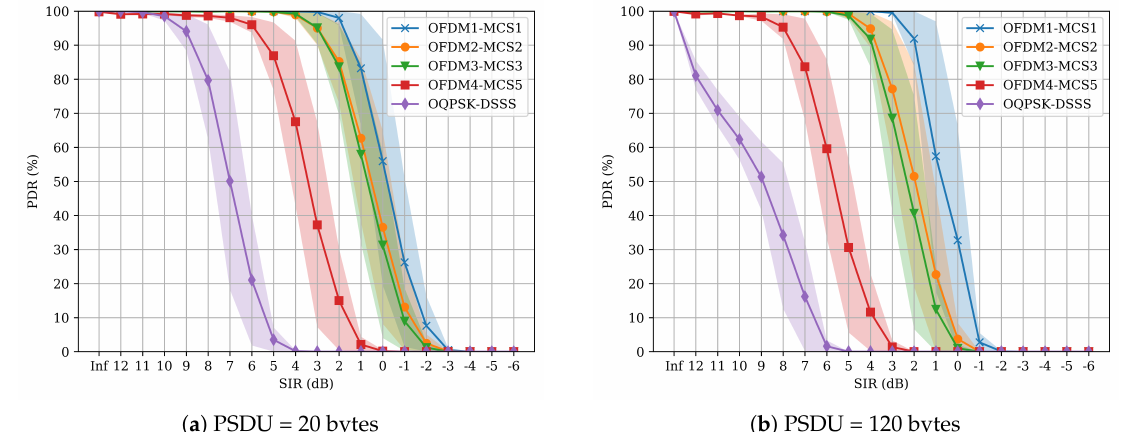
Figure 5. OFDM1-MCS1 interference results.